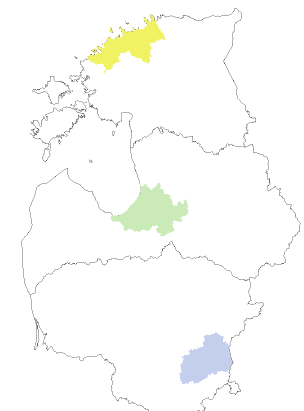
Fig. 2. FUA zones of the Baltic States (down from the top: Tallinn, Riga, Vilnius) (data source: European Comission,